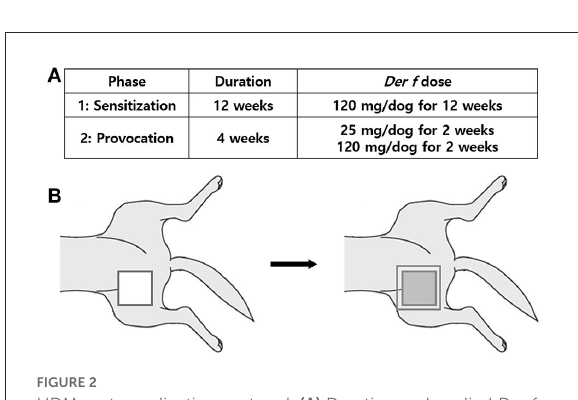
FIGURE2 HDM paste application protocol. (A) Duration and applied Der f dose in study phase 1 (Sensitization) and phase 2 (Provocation). (B) Application procedure. Clip the hair of the right groin, apply the HDM paste directly to 100 cm 2 area of the right groin skin as evenly as possible, then secure the application site with transparent bio-occlusive dressing, and place the plastic e-collars on the dogs. Der f , Dermatophagoides farinae